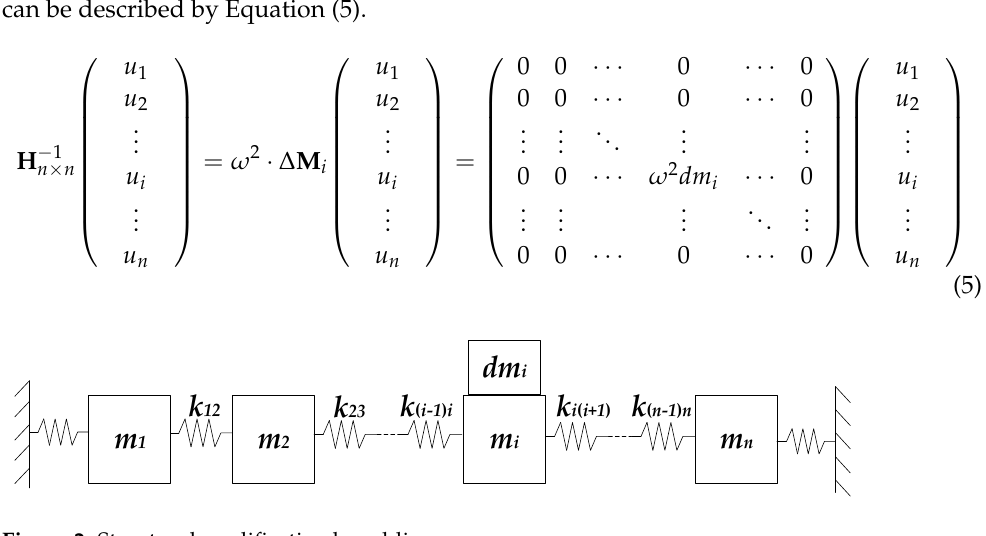
Figure 1. n-degree-of-freedom undamped vibration system.